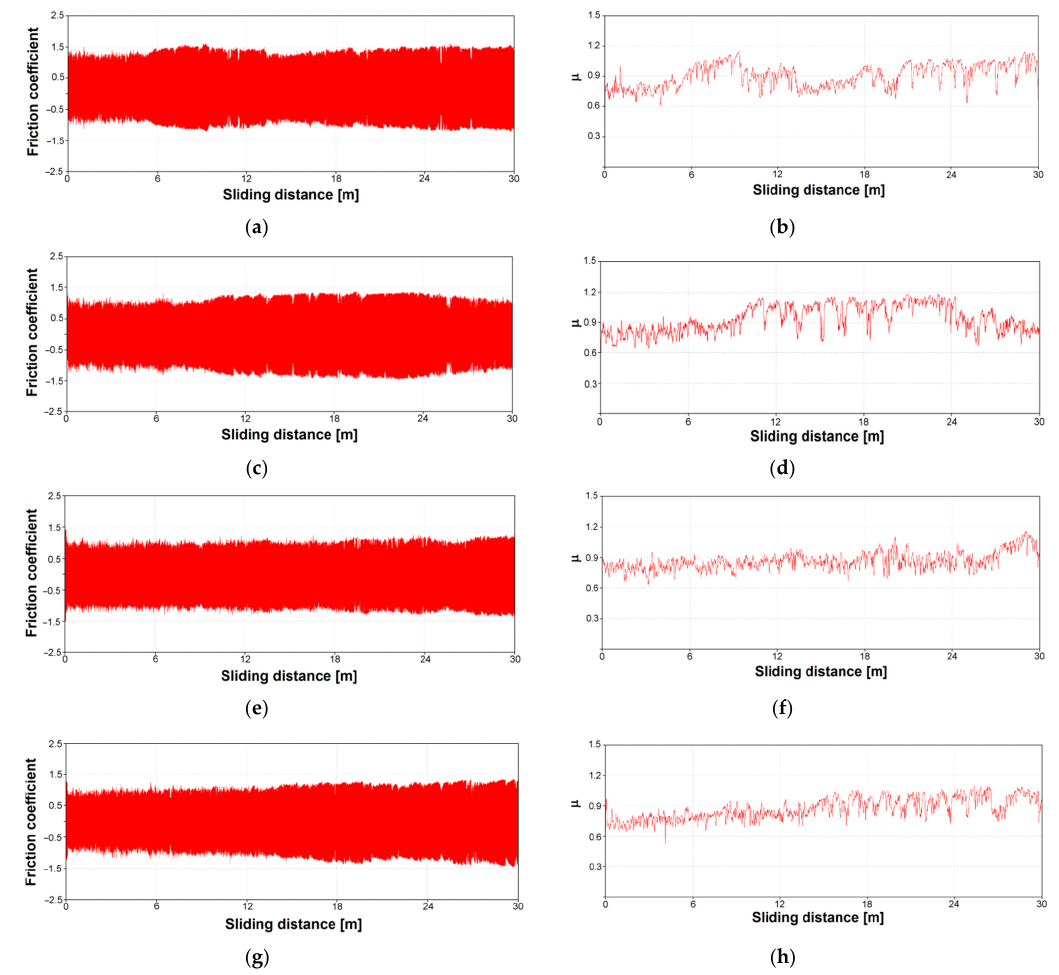
Figure 9. Friction coefficient ( μ ) as a function of the sliding distance in the ball-on-flat system for: ( a , b ) Ti–13Zr–13Nb alloy; ( c , d ) 1G ONT layer; ( e , f ) 2G ONT layer; ( g , h ) 3G ONT layer.